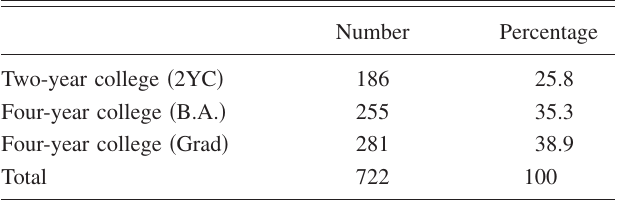
TABLE II. Institutional Affiliation of Respondents.